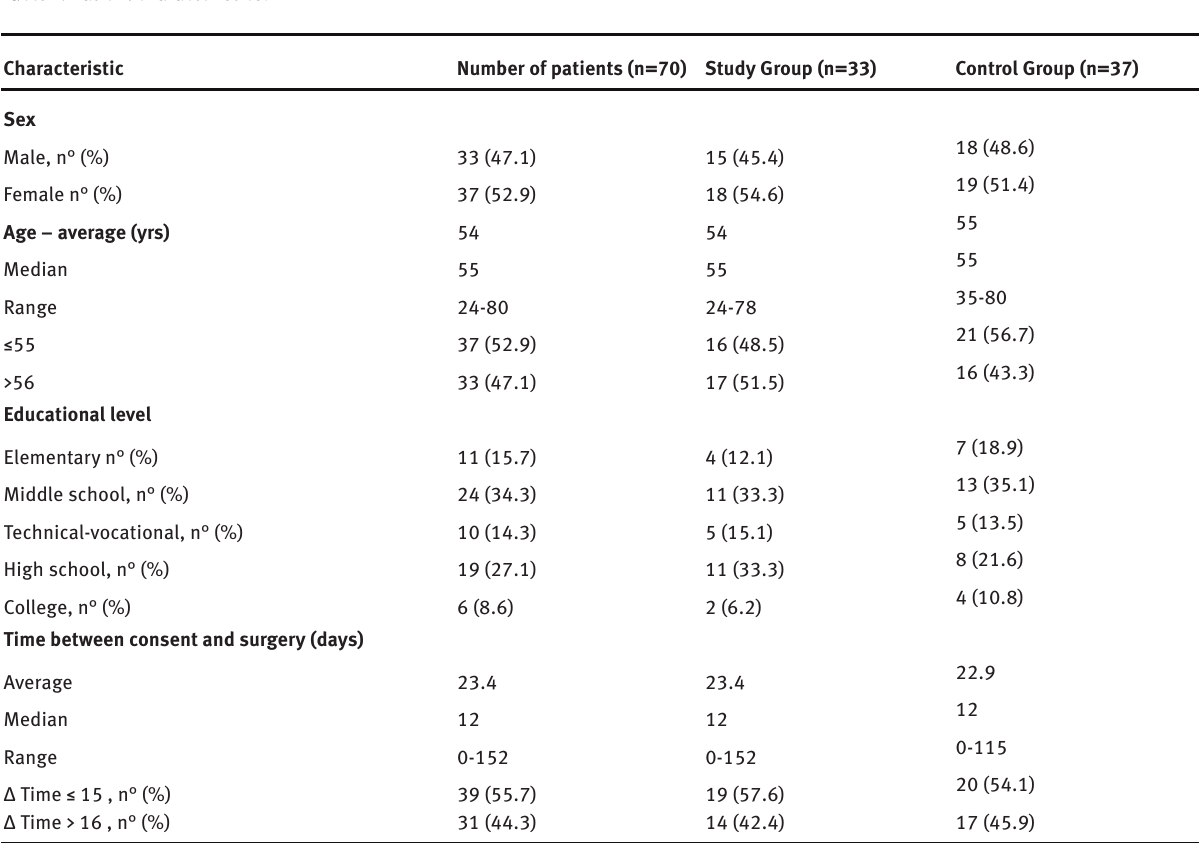
Figure 1: Simplified informed consent Table 1: Patient characteristics.